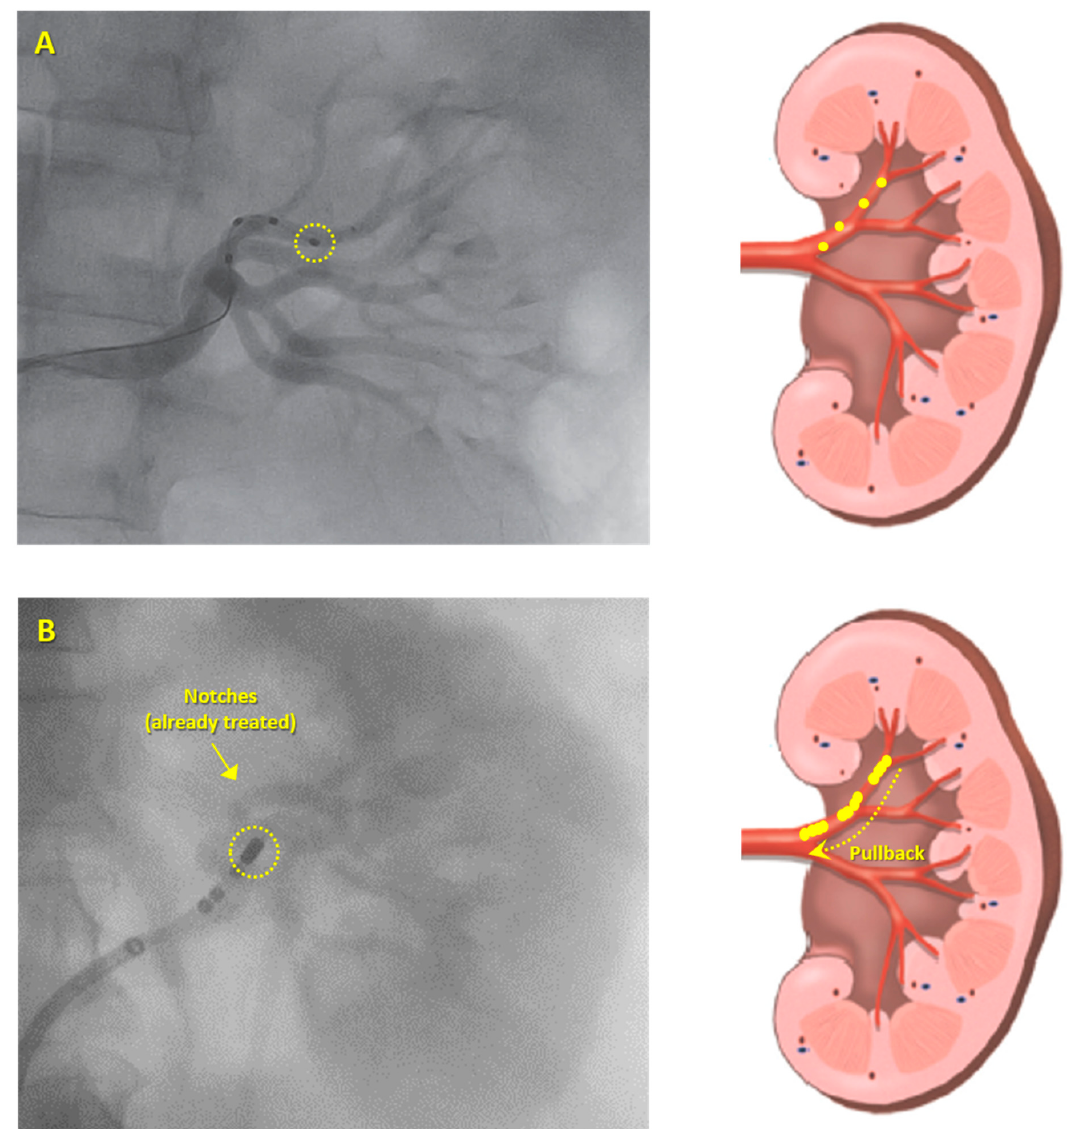
Figure 1. Types of renal denervation approach used. ( A ) Symplicity Spyral multielectrode renal denervation (RDN) catheter (Medtronic, Galway, Ireland) which allows simultaneous or sequential energy treatments into a left renal artery (each one out of four electrodes is 1 mm in length). ( B ) 7-Fr standard irrigated cardiac ablation catheter with a 3.5 mm electrode tip length (AlCath Flux eXtra Gold Full Circle 270°; VascoMed GmbH, Binzen, Germany) was inserted into a left renal artery and was moved in a circumferential pullback fashioned from the distal to the proximal renal artery segment. Yellow dots represent ablated spots.